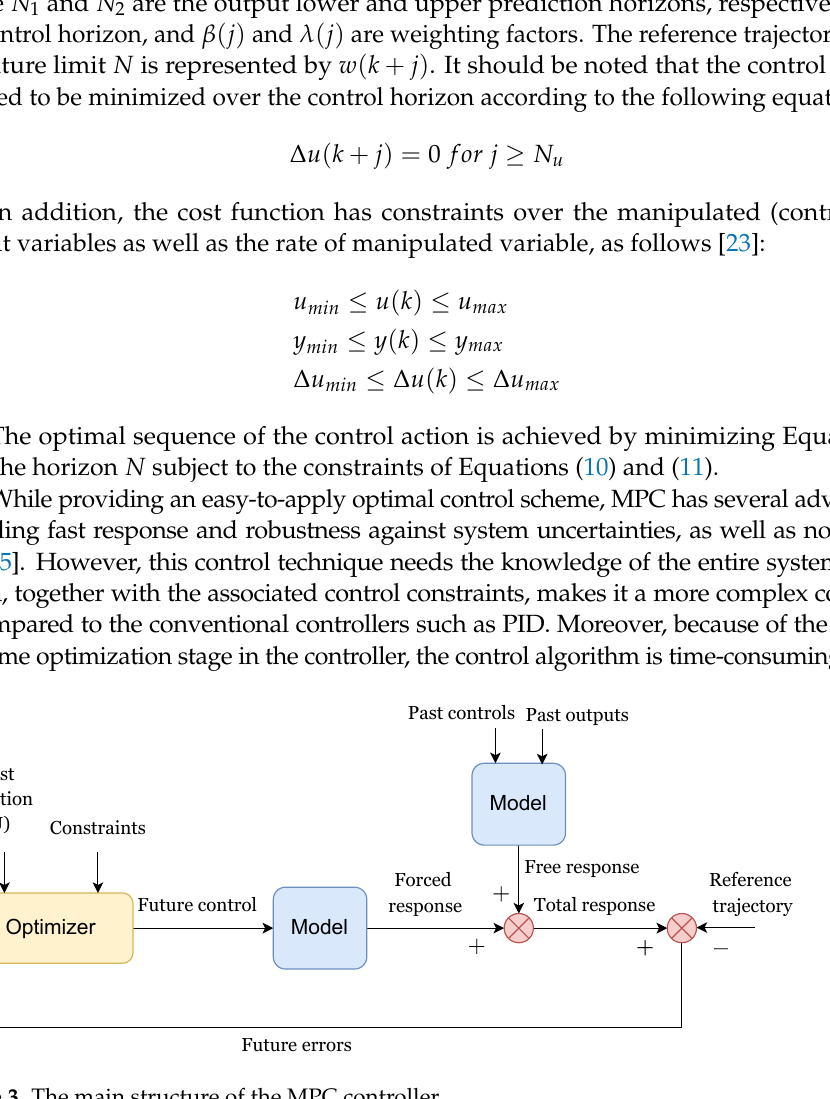
Figure 3. The main structure of the MPC